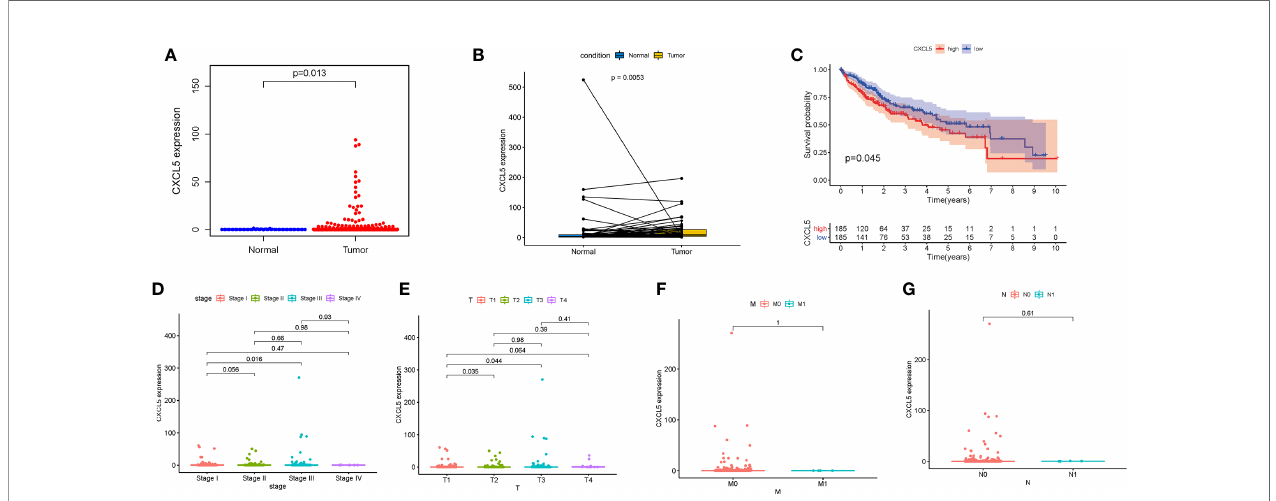
FIGURE 5 | The differentiated expression of CXCL5 and correlation with survival and clinical characteristics. (A) Differentiated expression of CXCL5 in the normal and tumor sample; (B) Paired differentiation analysis for expression of CXCL5 in the normal and tumor sample deriving from the same one patient; (C) Survival analysis for HCC patients with different CXCL5 expression; (D – G) The correlation of CXCL5 expression with clinical